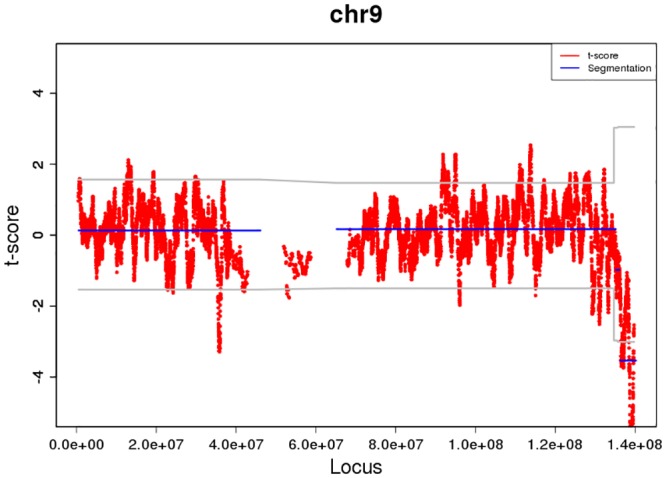
False positive results of sample INC6 by FCAPS showing CNV location near to telomere.